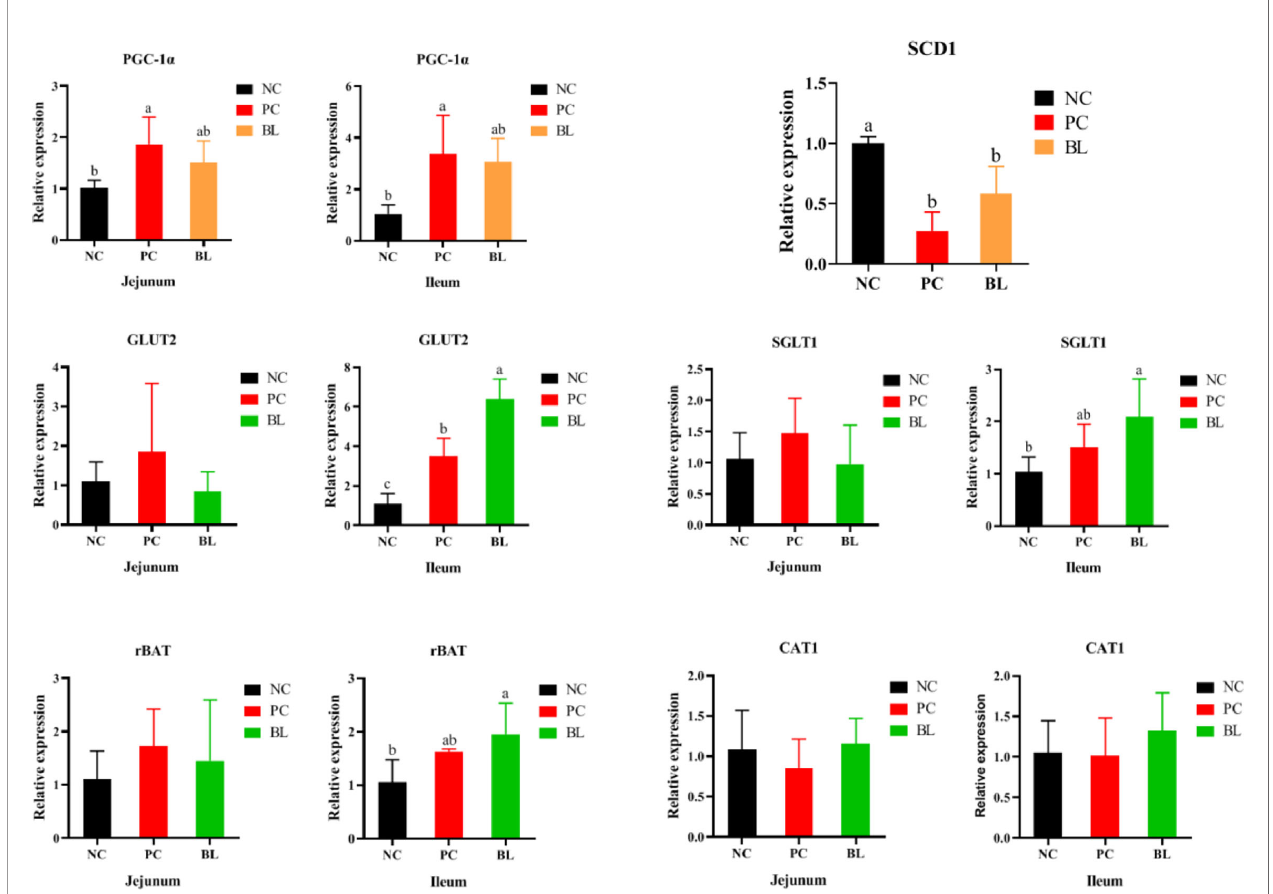
FIGURE 6 | Relative mRNA expressions of PGC-1 a , SCD1, GLUT2, SGLT1, rBAT, and CAT1 of broiler chickens (n = 6, mean with SD). a, b means those with different letters are signi fi cantly different ( P < 0.05). One-way ANOVA and adjustment for multiple comparisons were